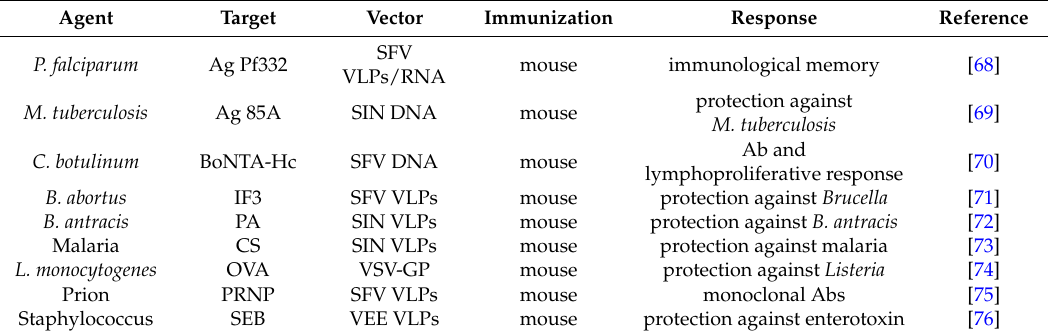
Table 2. Self-Replicating RNA Viral Vector-Based Immunizations against Infectious